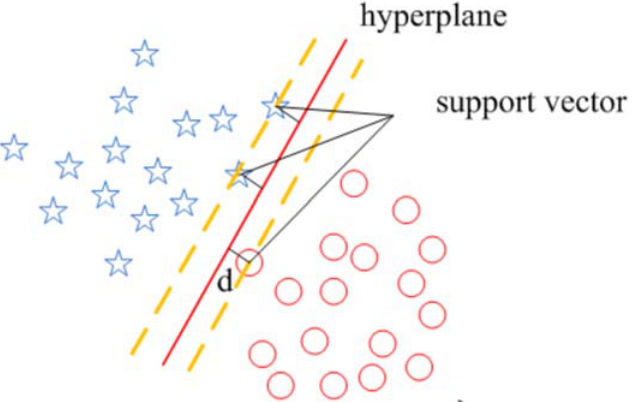
Figure 2. Schematic diagram of SVM. “d” means the largest diatance between the support vector and hyperplane.